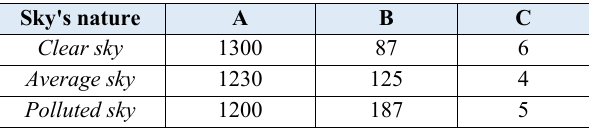
Table (1): The values of the coefficients (A, B, and C) Sky's nature A B C Clear sky 1300 87 6 Average sky 1230 125 Polluted sky